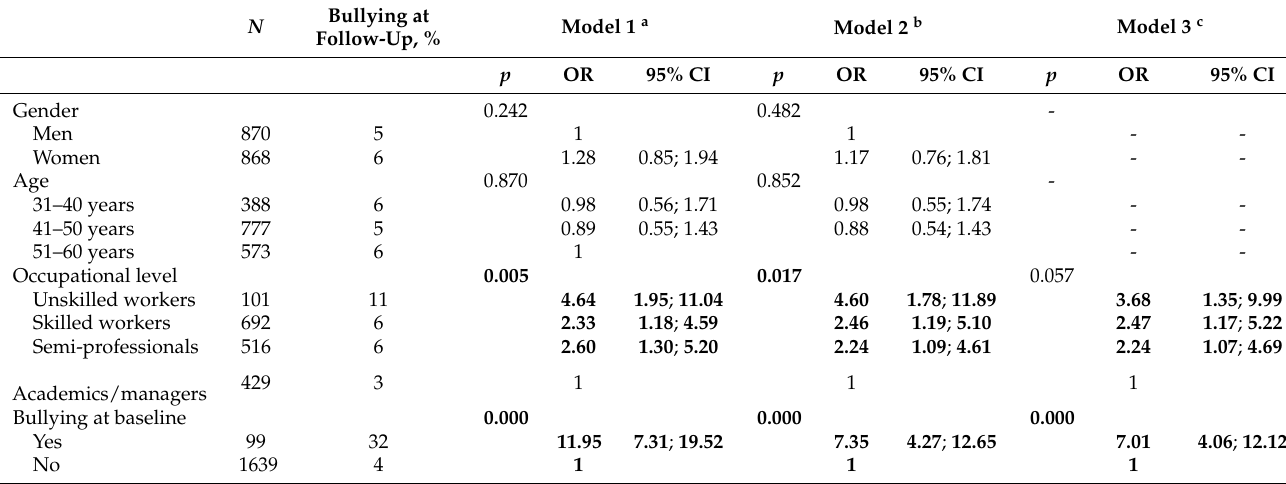
Bold numbers indicate significance level < 0.05. a Each covariate unadjusted. b Additionally adjusted for working conditions (organisational restructuring, organisational layoffs, work pace, amount of work, influence at work, role clarity, quality of leadership). c All covariates mutually adjusted and adjusted for baseline workplace